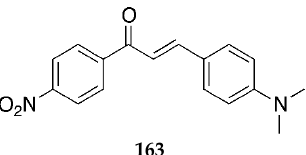
Figure 58. Chemical structure of the N,N -dimethyl-4′-aminochalcone derivative with nitro substitution on ring A.